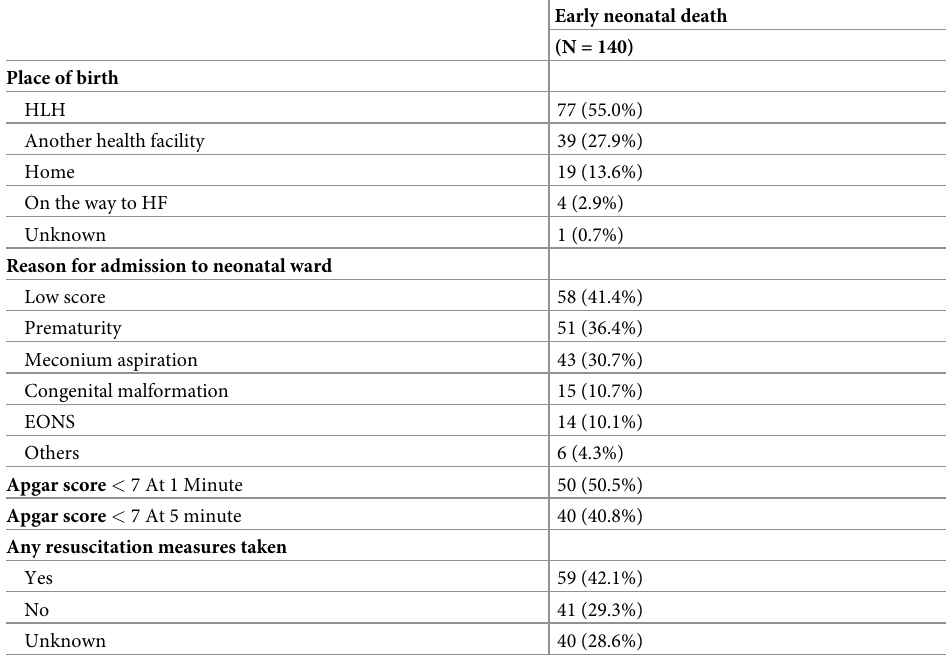
Table 4. Characteristics of early neonatal death.